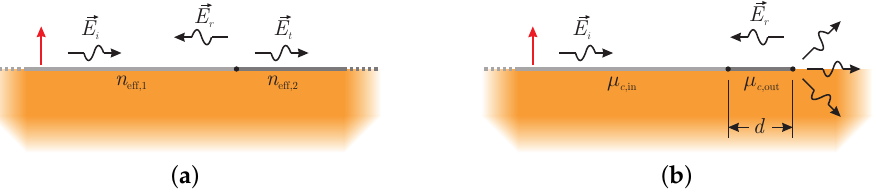
Figure 2. Surface wave propagation on graphene towards ( a ) a layer with different properties and ( b )